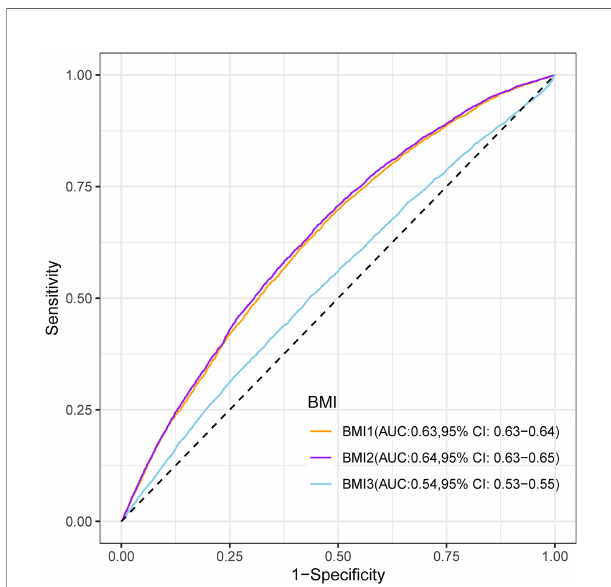
FIGURE 2 | Receiver-operating characteristic curves for the prediction of macrosomia by maternal pre-pregnancy BMI (BMI1), maternal fi rst-trimester BMI (BMI2), and paternal pre-pregnancy BMI (BMI3). BMI, body mass index; AUC, area under the receiver-operating characteristic curve; CI, con fi dence intervals.